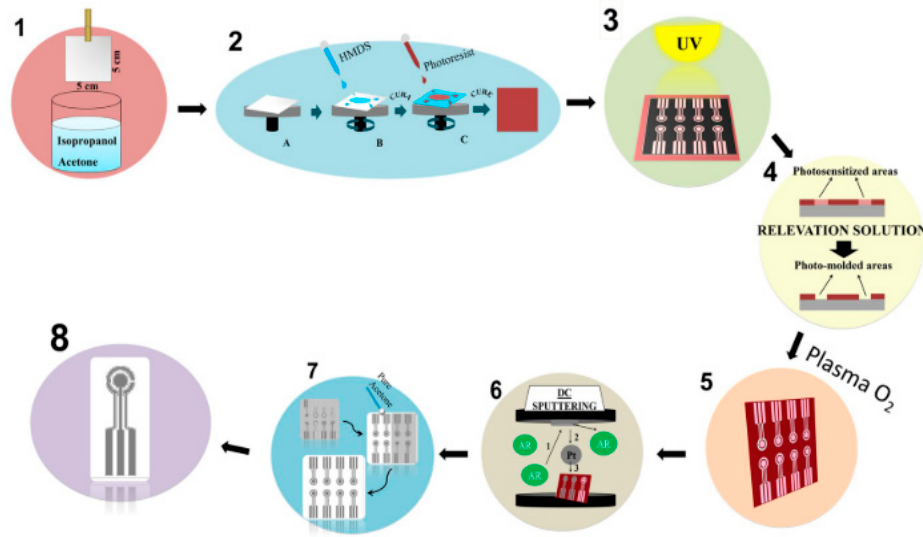
Figure 18. ( 1 ) Bio-polyethylene terephthalate (PET) pretreatment; ( 2 ) photoresist deposition on substrate; ( 3 ) exposure to ultraviolet radiation for electrode delimitation; ( 4 ) removal of the sensitized photoresist with the developer solution, followed by washing and drying; ( 5 ) patterned substrate treatment with O 2 plasma; ( 6 ) substrate treatment with O 2 plasma; ( 7 ) removal of excess coating and washing material; ( 8 ) individually cut flexible platinum electrodes. Reprinted with permission from reference